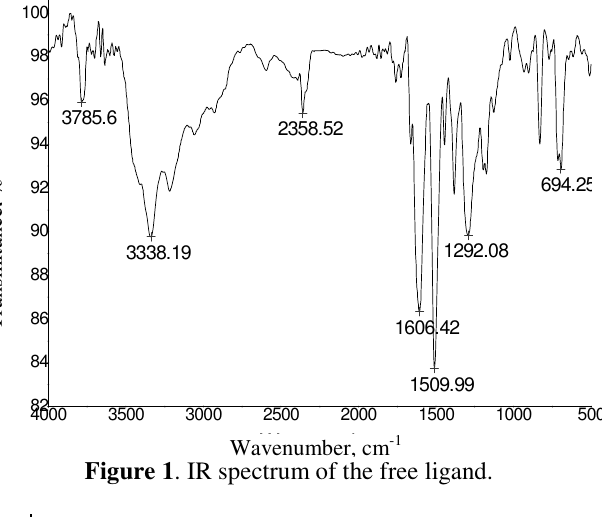
Figure 1 . IR spectrum of the free ligand.